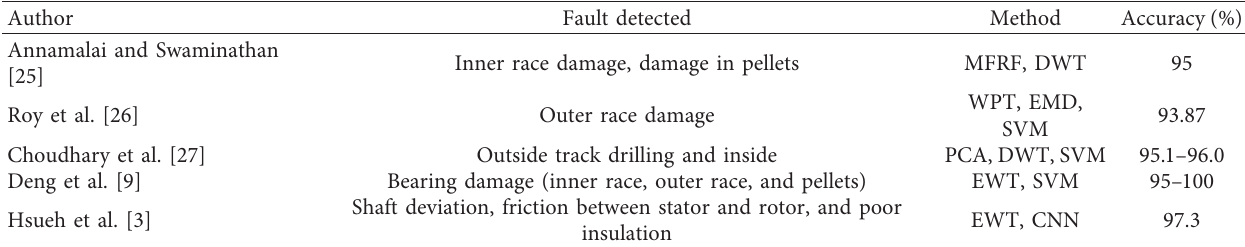
Table 3: Related approaches.